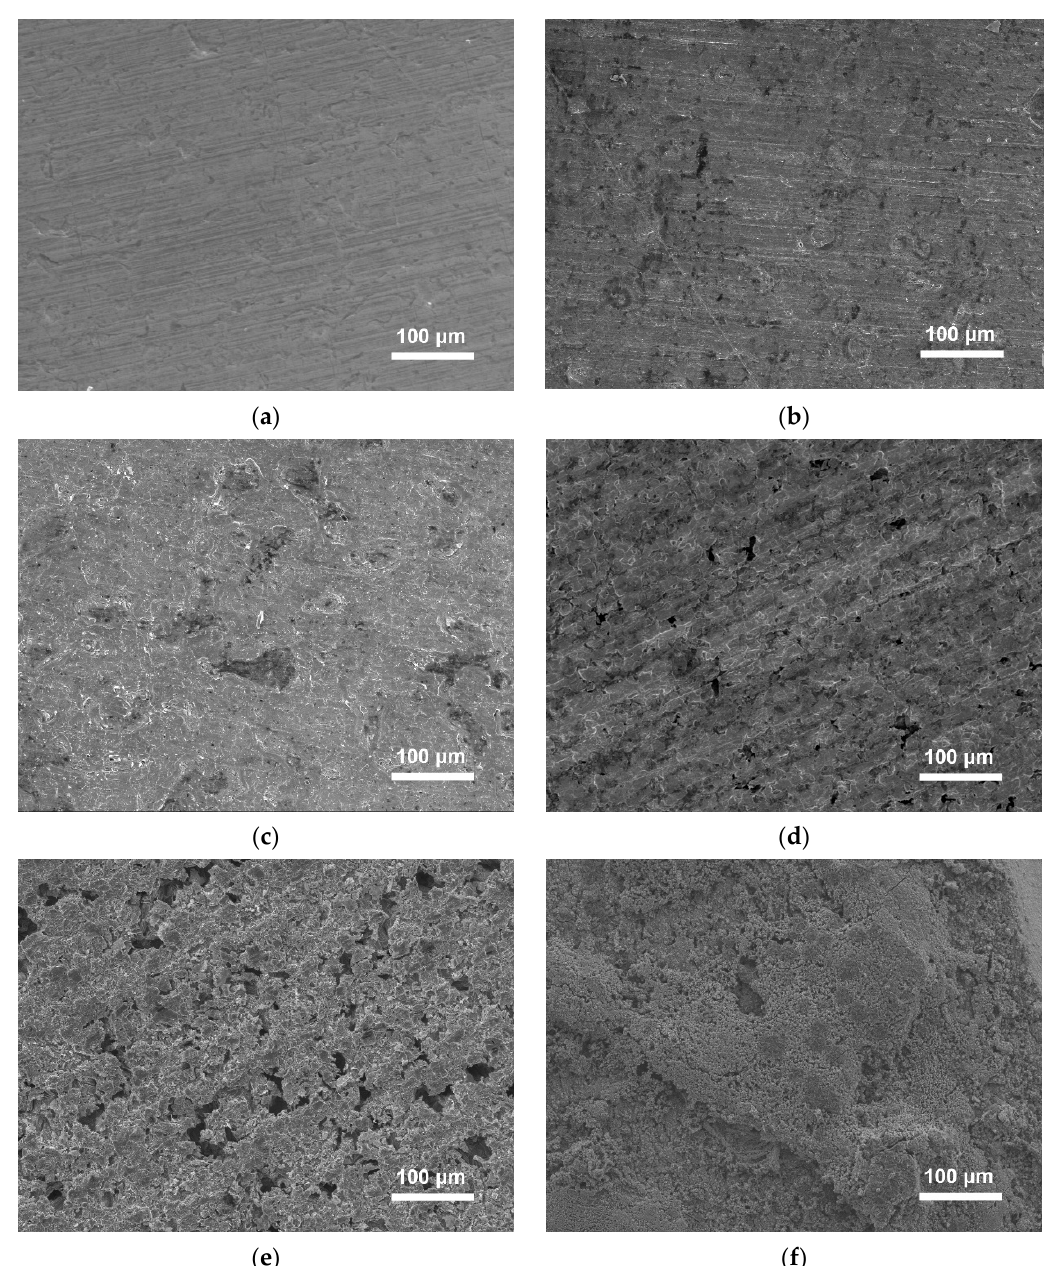
Figure 4. Low magnification SEM images of the surface morphology of the ( a ) fresh zinc sheet, and zinc anode in the batteries stored for ( b ) 2 days; ( c ) 4 days; ( d ) 7 days; ( e ) 10 days; ( f ) 20 days.